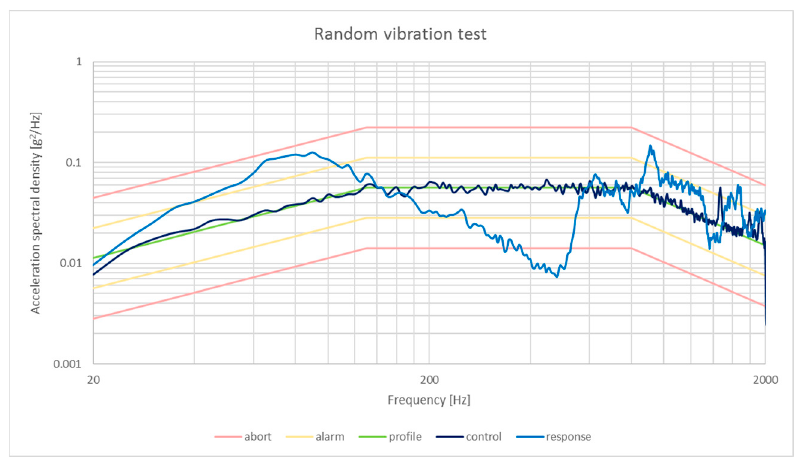
Figure 13. Results of a random vibration test.